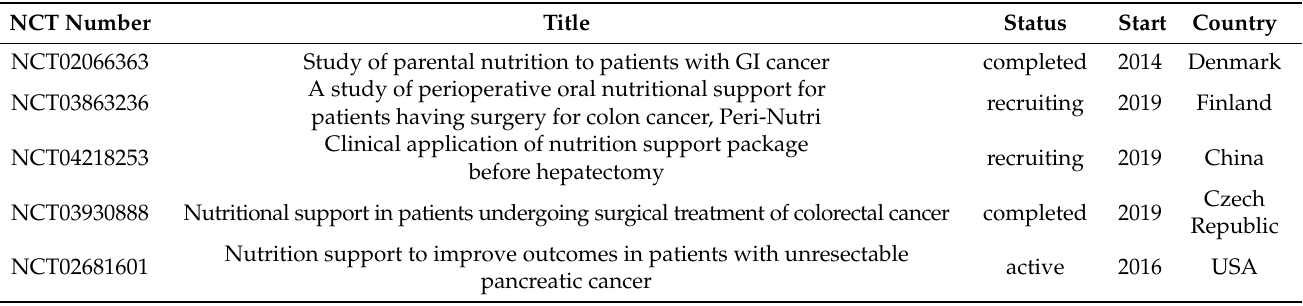
Table 1. Clinical trials for GI cancer patients concerning nutritional